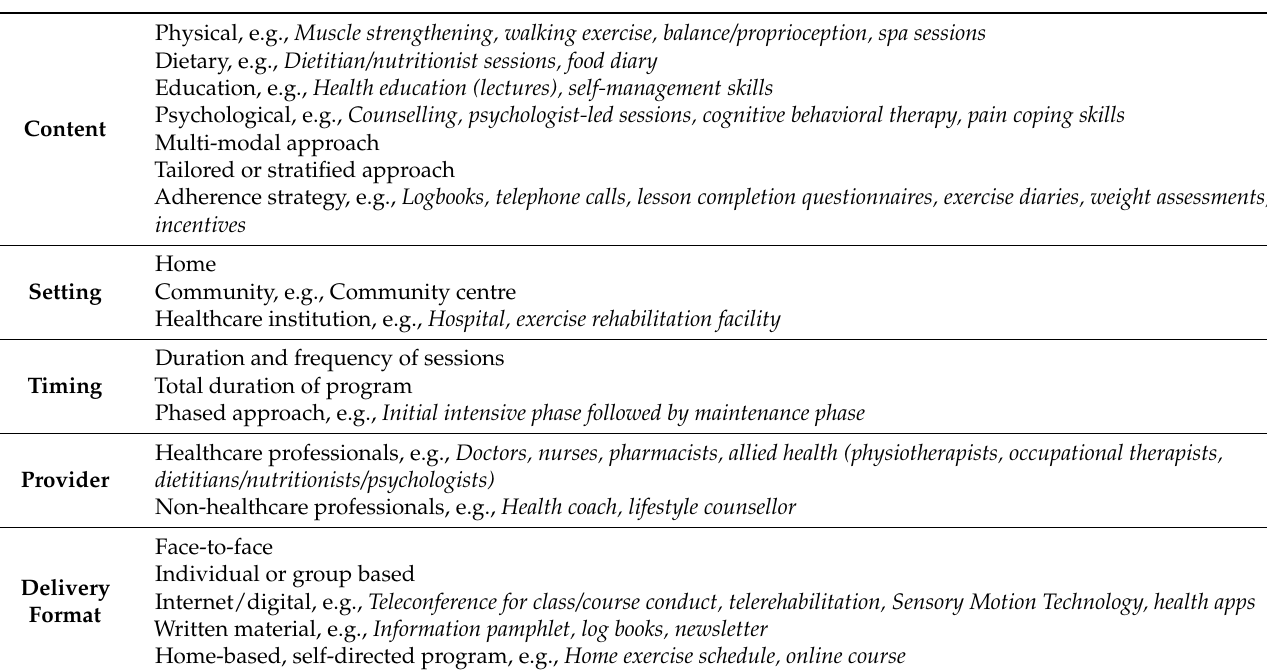
Figure 2. Venn diagram of the different intervention combinations. Table 3. Summary of various interventions.